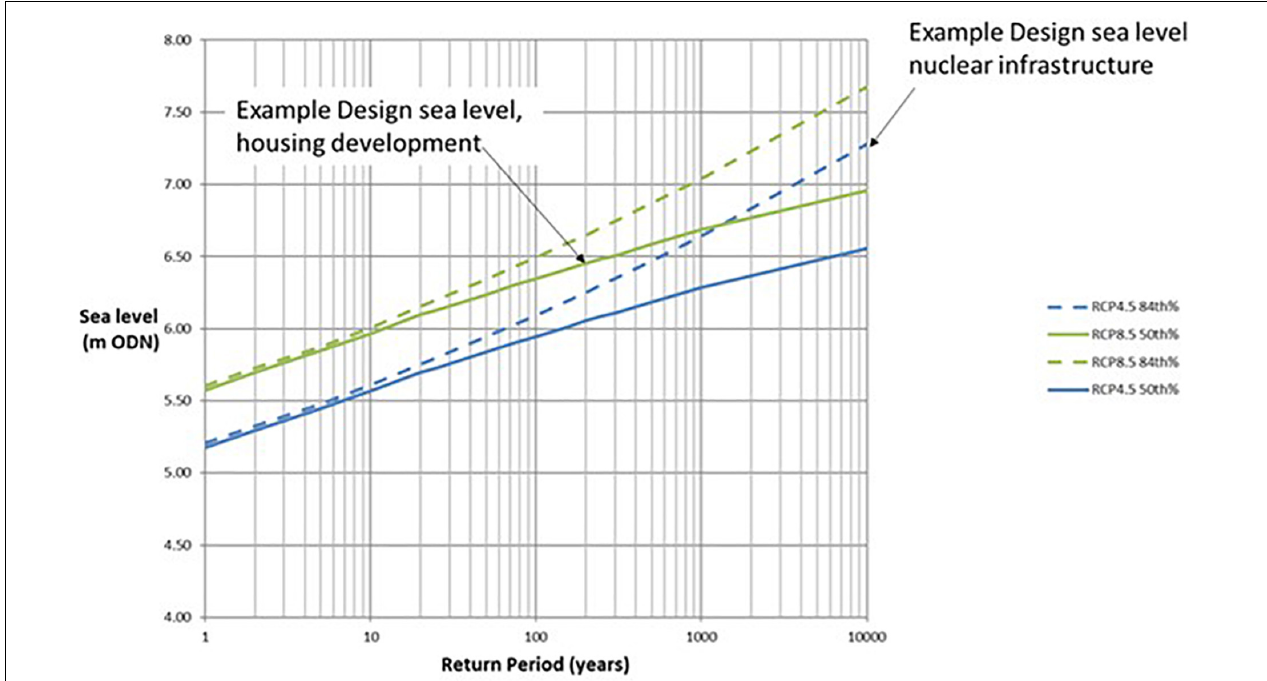
FIGURE 1 | Illustrative exemplar estimates of extreme sea levels for the year 2100 for different end applications for a hypothetical site. The figure utilizes the 9th percentile SLR estimate of the RCP8.5 and 4.5 scenarios, respectively. The percentile annotated in the legend relates to the uncertainty associated with the extrapolation of historical data to extreme